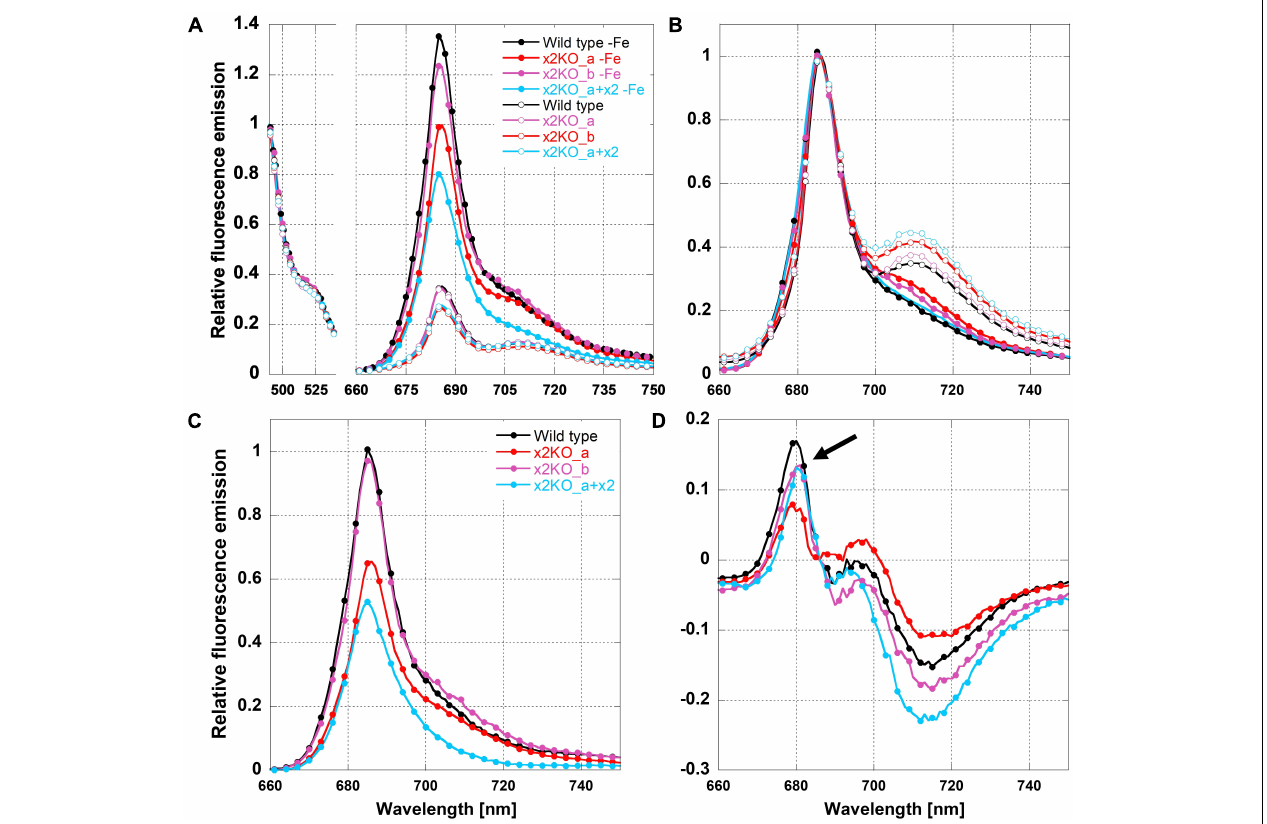
FIGURE 6 | Relative 77K fluorescence emission spectra of iron-limited and replete Phaeodactylum tricornutum wild type and mutant strains. (A) Spectra normalized to the emission peak of green fluorescence protein (GFP), which was added as an internal standard. (B) Spectra normalized to the emission peak of Chl a at 686 nm. (C) Difference of 77 K fluorescence emission spectra of iron-deficient minus iron-replete cells normalized to the GFP emission. (D) Difference of 77 K fluorescence emission spectra of iron-deficient minus iron-replete cells normalized to the Chl a fluorescence emission peak at 686 nm. The arrow indicates fluorescence emission of FCPs not connected to the